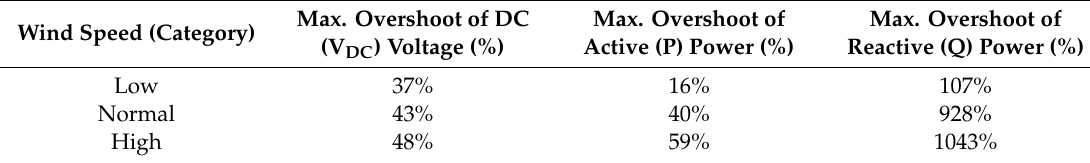
Table 2. Numerical results for normal operation under wind speed variations. TSR, tip speed ration. Wind